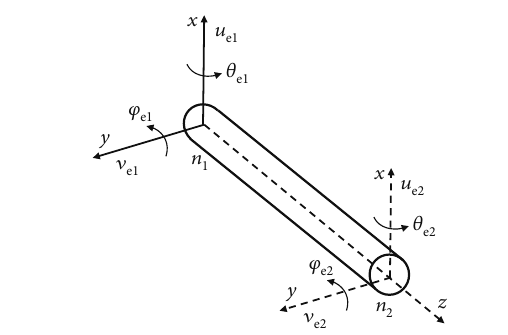
Figure 4: Diagram of SFD.